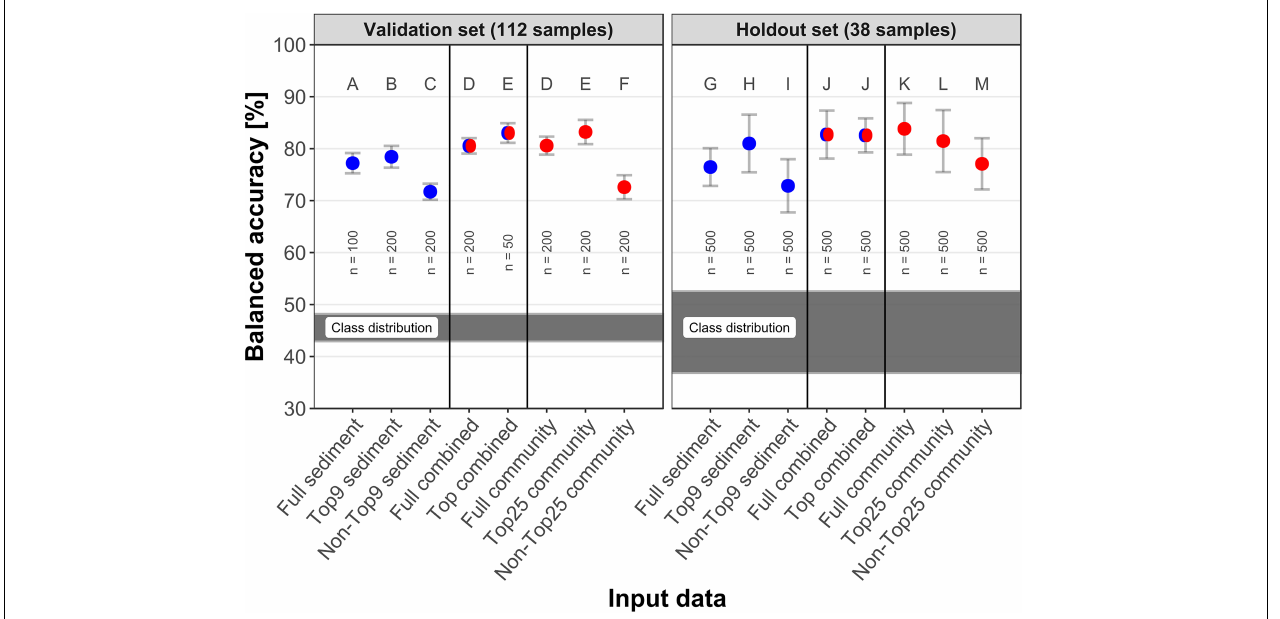
FIGURE 2 | Correct TNT classifications per input data in the validation and holdout test set. Red indicates community data, blue symbolizes sediment data and red-blue combined variables. Of each data type, either all variables were utilized by the model (“Full”), or only the best variables based on variable importance (“Top”) or all variables except Top (“Non-Top”). Classification performance is displayed as mean and standard deviation of balanced accuracy, the classification results of the six different data set splits were averaged. The validation values are out-of-bag estimates. The letters indicate which groups were significantly (adjusted p < 0.005) different to all other groups within the data set. The shaded area indicates the distribution of samples containing TNT among the six data set splits. n indicates the number of models